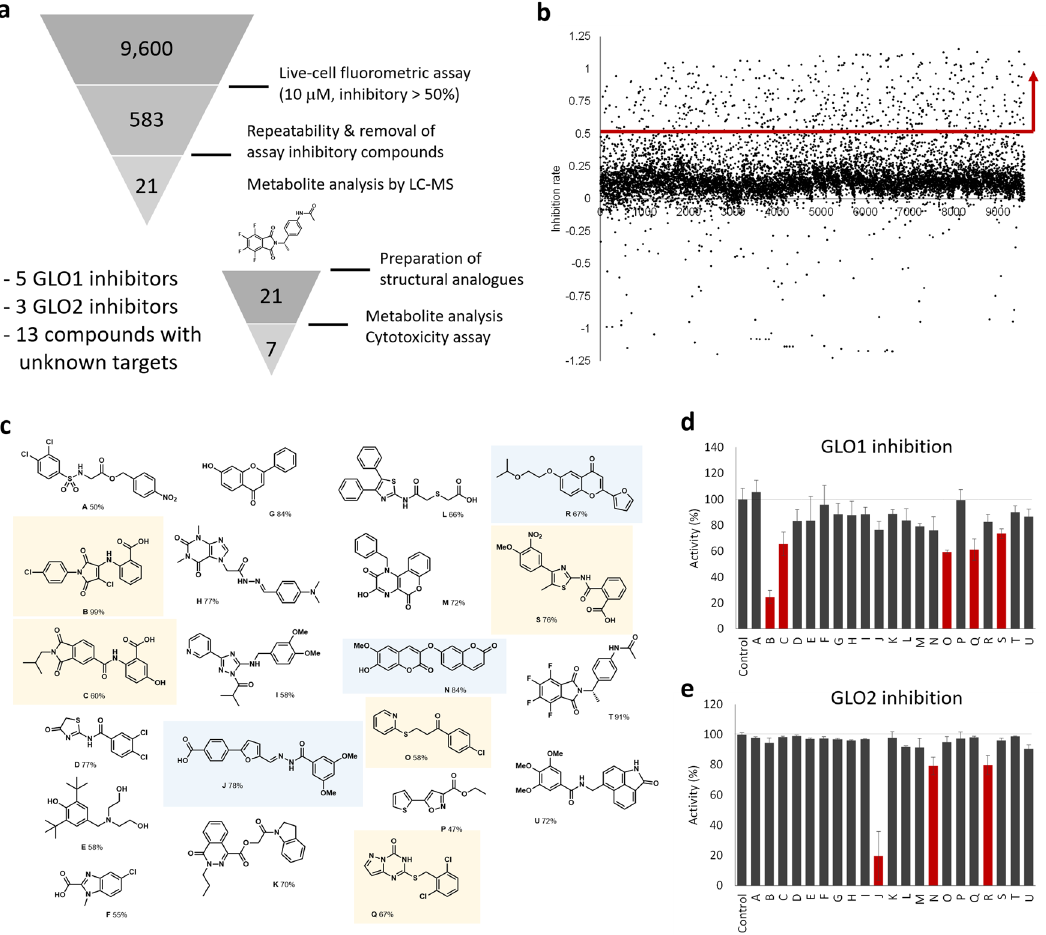
Fig. 3 Screening of compounds that affect glyoxalase pathway of DMS114 cells. a Flow of screening. b Summary results of 1st screening. c Structures of hit compounds that blocked the glyoxalase pathway activity of DMS114 cells. Numbers indicates the inhibition % of the activity. Yellow highlighted compounds blocked GLO1 activity, and blue highlighted compounds blocked GLO2 activity. d Activities of recombinant GLO1 (0.1 μ g/mL) after mixing with MG (100 μ M), GSH (1 mM) and inhibitors (10 μ M) in PBS (pH 7.4) and incubating for 10 min. The formation of SLG was monitored by LC-MS, and the percentage of the activity was calculated compared with conditions without inhibitors. Error bars represents S. D. ( n = 3). Red bars indicate compounds with inhibition of >30% with P < 0.05 (Student ’ s t -test). e Activities of recombinant GLO2 (0.17 μ g/mL) after mixing with SLG (100 μ M) and inhibitors (10 μ M) in PBS (pH 7.4) and incubating for 30 min. The consumption of SLG was monitored by LC-MS, and the percentage of the activity was calculated compared with conditions without inhibitors. Error bars represents S. D. ( n = 3). Red bars indicate compounds with inhibition of >30% with P < 0.05 (Student ’ s t